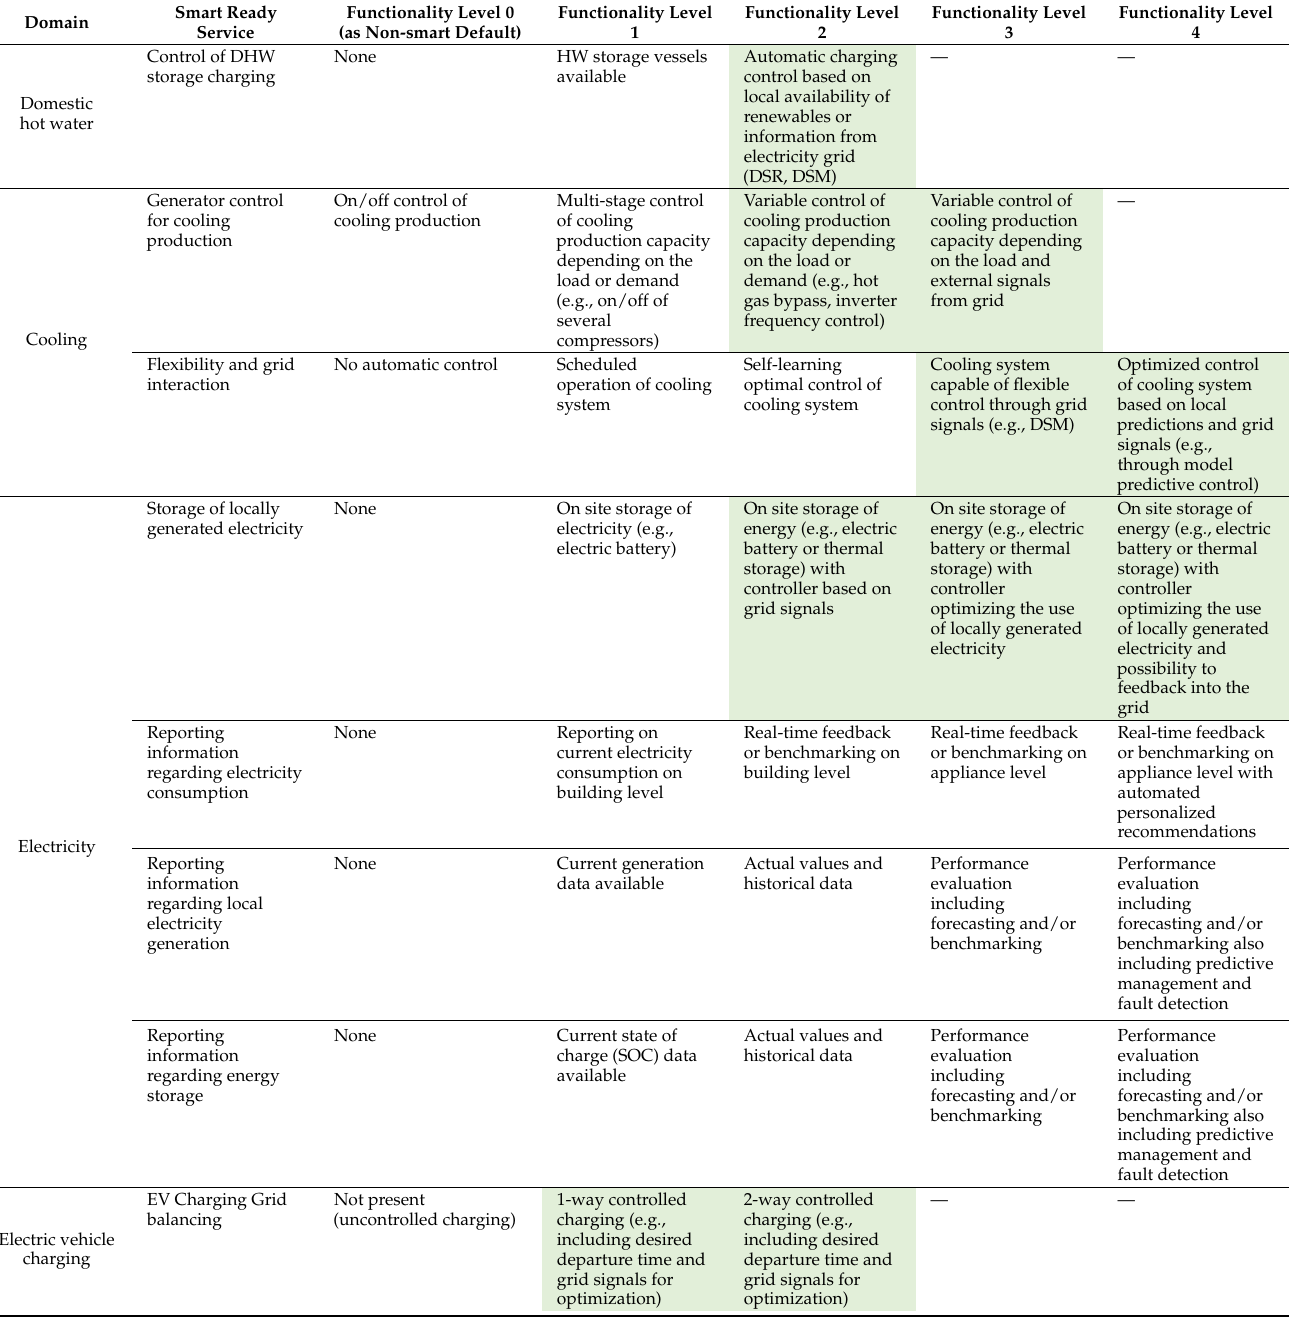
Table 3. Selected services/functions from the catalogue of services provided by the SRI develop- ment report for simplified assessment method A and directly related to prosumers’ installations in residential houses and small public, commercial buildings